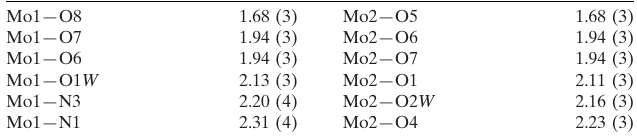
Selected bond lengths (A˚ ).